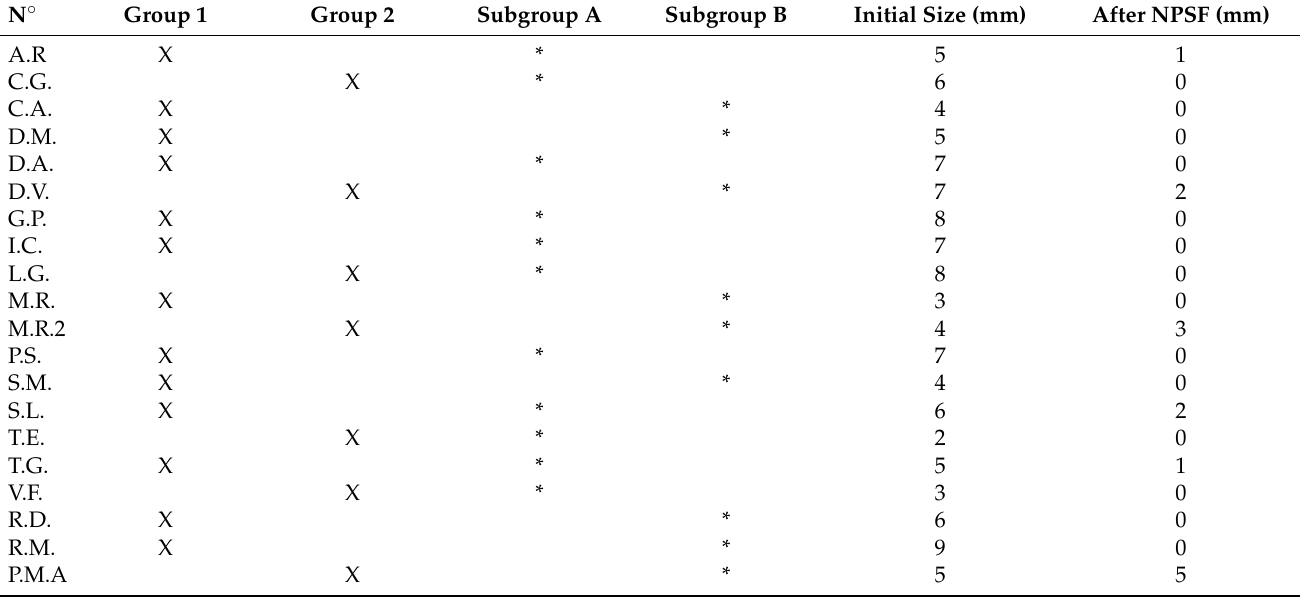
Table 4. Sizes of the